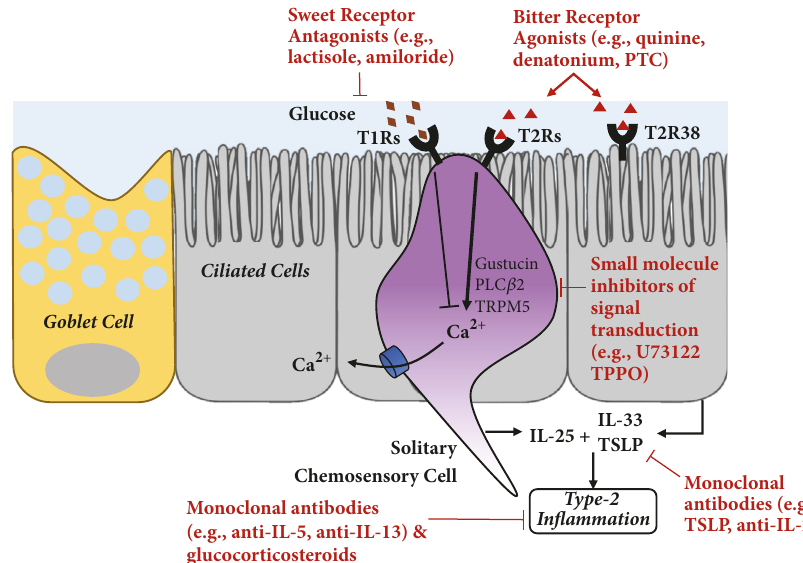
Figure 3: Potential targets for therapeutic intervention in the taste receptor pathway. Inhibitors of sweet receptors and agonists of bitter taste receptors may potentiate innate immune responses from ciliated cells and SCCs. In addition, small molecular inhibitors are known to block signal transduction but have only been used experimentally. Inhibitory monoclonal antibodies, such as anti-TSLP as well as anti- IL-5 and IL-13, have also recently entered the market or are undergoing clinical investigation (U73122 inhibits Phospholipase C; TPPO = triphenylphosphine oxide inhibits